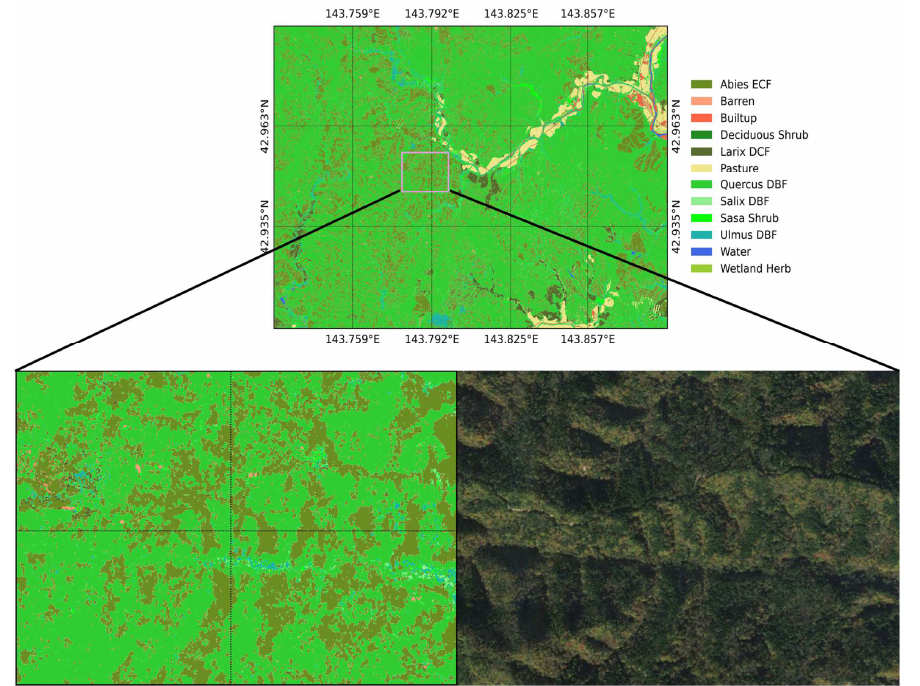
Figure 18. Ultra-resolution map with 12 classes produced for the Shiranuka site ( top ). The red polygon area has been zoomed in to show finer details ( bottom left ) along with the true-color composite image ( bottom right ).